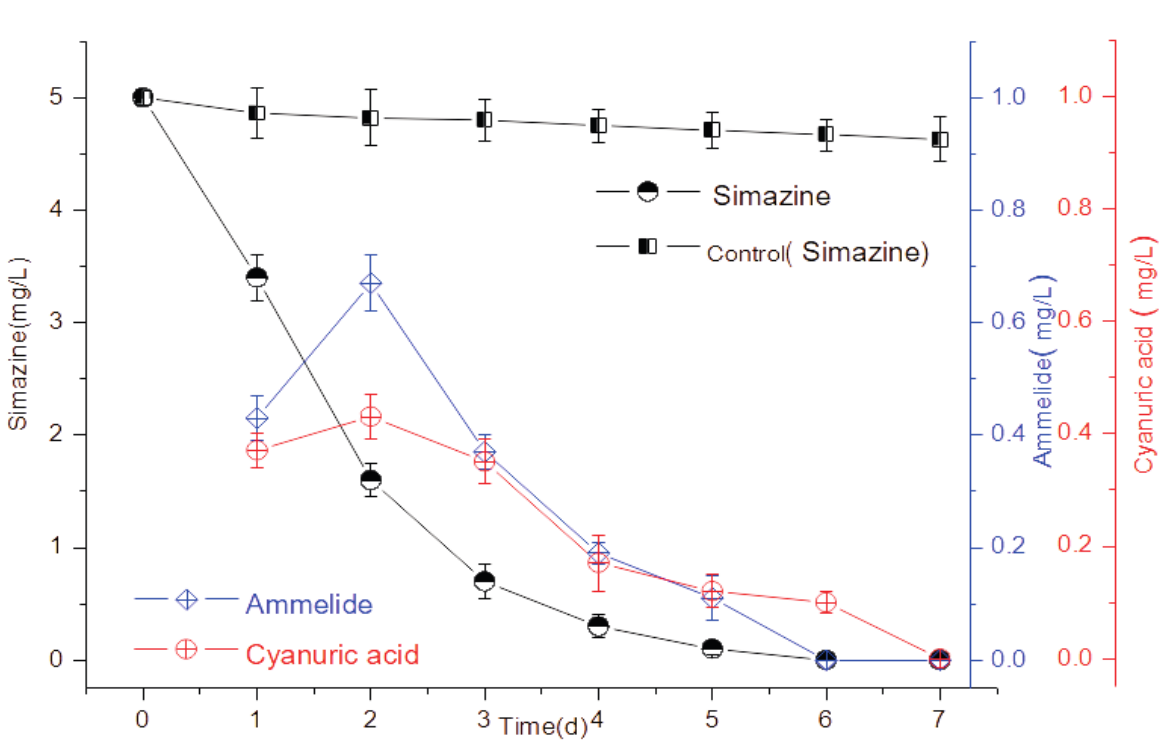
Figure 4. The curve on degradation of simazine by the strain SIMA-N9 (n=5).